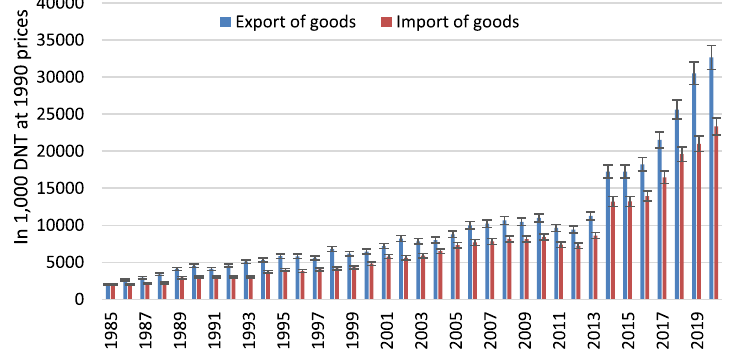
Fig. 2 Evolution of Tunisia’s export and import of goods (in 1000 DNT at 1990 prices). Source Compiled by the author from data collected from several issues of the Statistical Yearbook of Tunisia (NIS 2020)